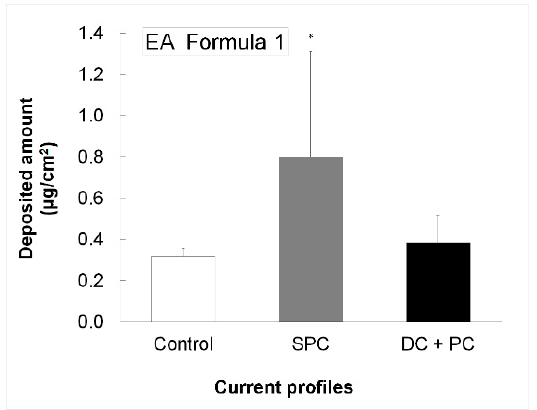
Figure 5. Deposited amount of EA obtained with EA Formula 1 at 0.2 mA/cm 2 applied for 5 min ( n = 6). * Denotes statistically significant difference with respect to the corresponding control.